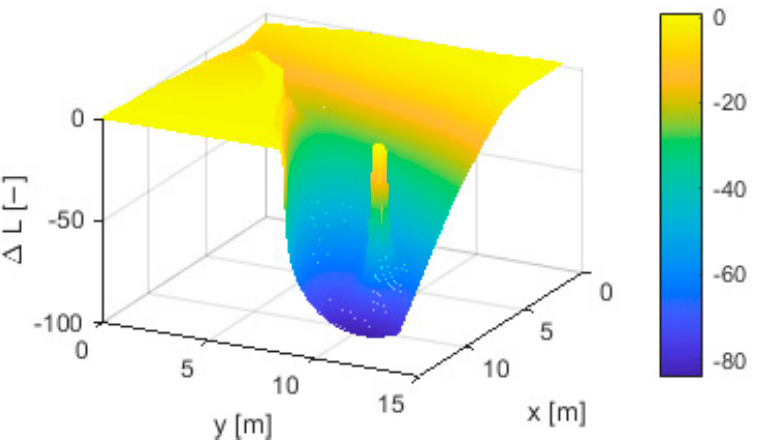
Figure 17. Interest zone enlargement of the results of the Lyapunov increment function ∆𝐿 over the entire navigation area Agent J.